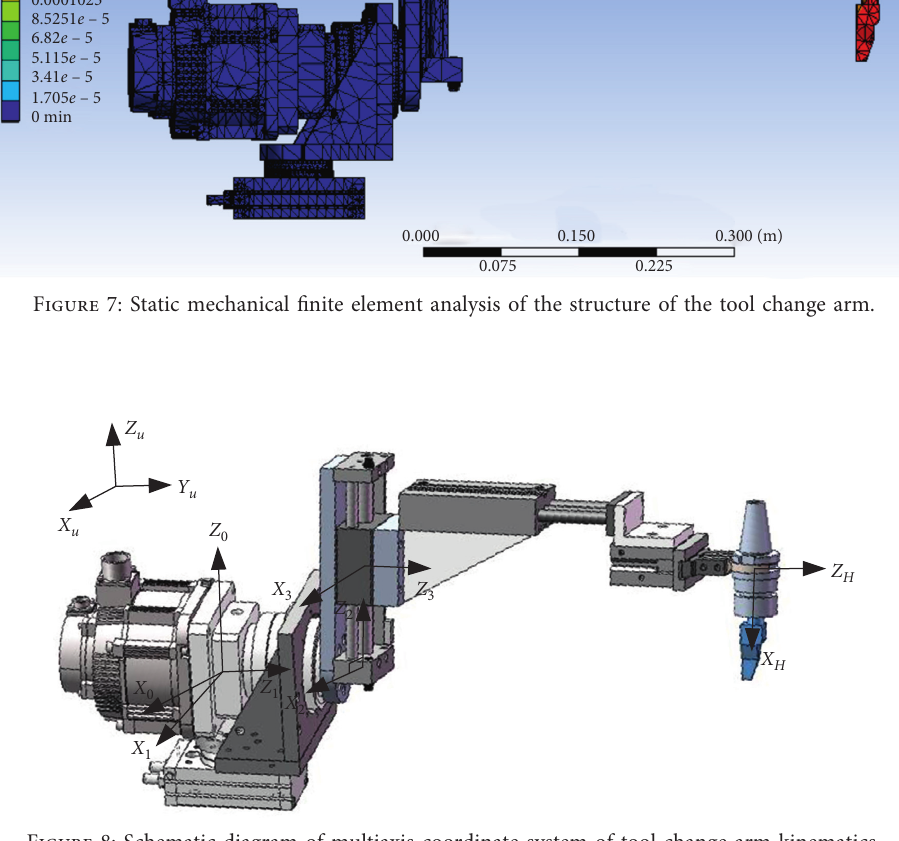
Figure 8: Schematic diagram of multiaxis coordinate system of tool change arm kinematics.